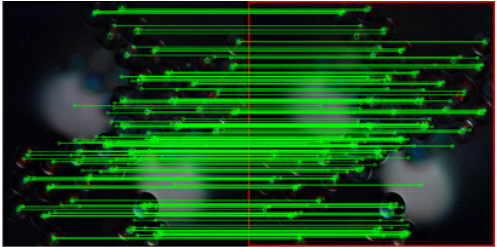
Figure 6. Keypoint matching between a reference and a retake CSR response. Keypoints in both images are represented as circles. Green lines represent correct matches.